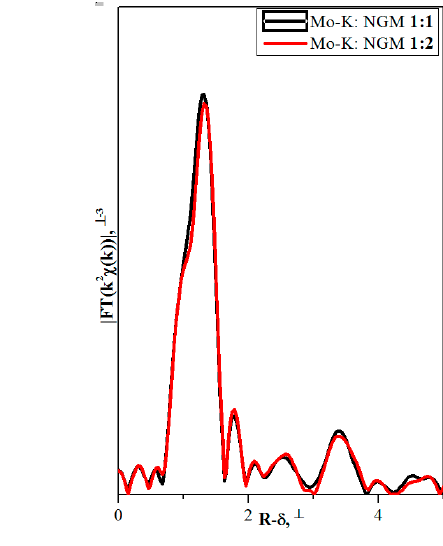
Figure 4. Gd L 3 -edge-normalized ( a ) XANES spectra and ( b ) EXAFS Fourier transforms for